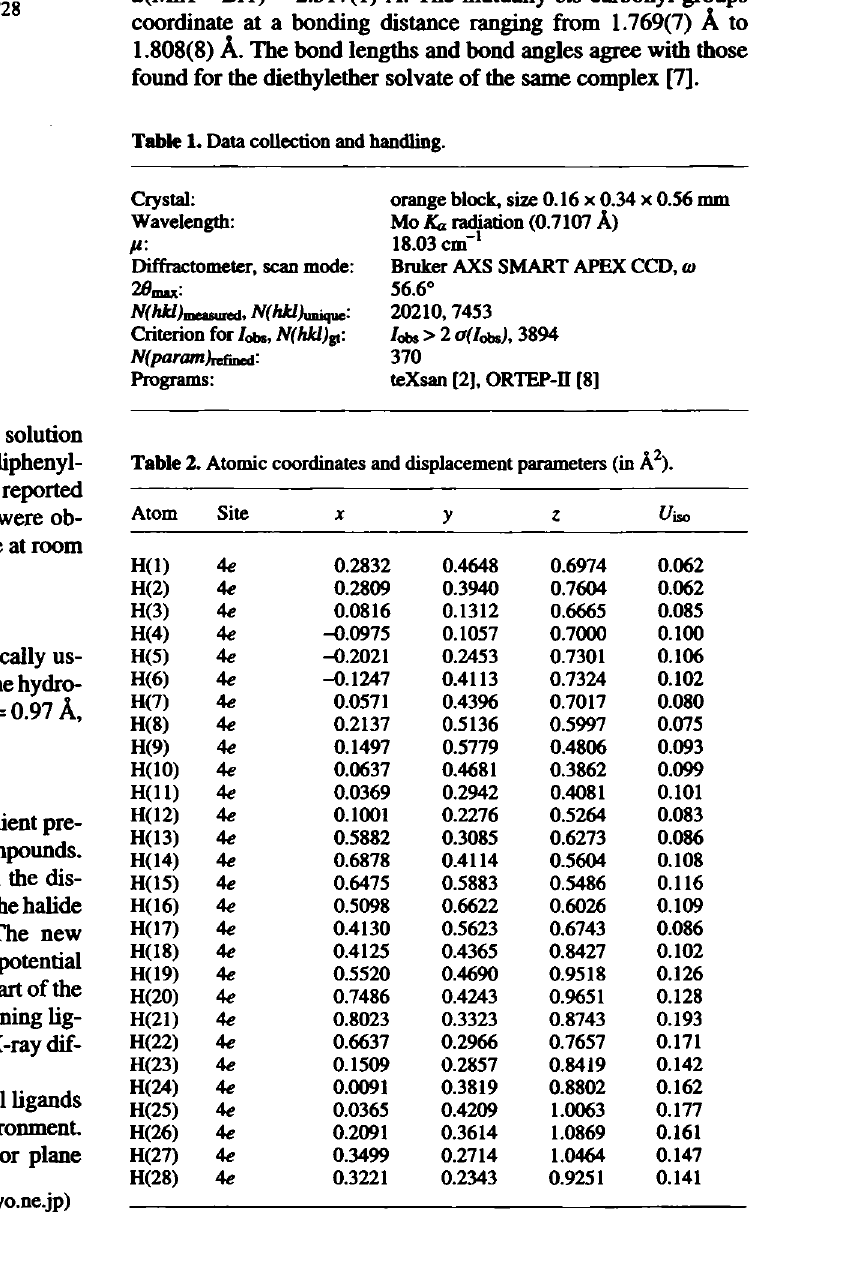
Table 1. Data collection and handling.